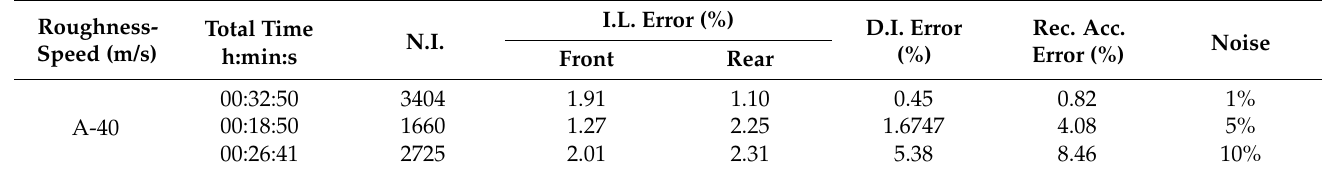
Table 8. Identification results at different noise levels and vehicle speed- road roughness A.